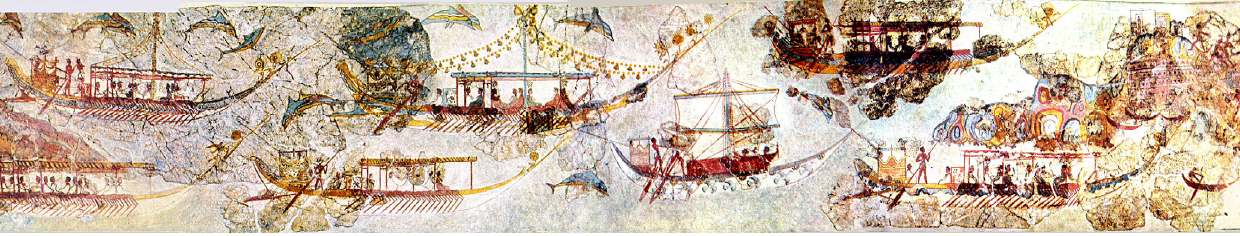
Figure 19. Minoan fresco, ship procession from Akrotiri c. 2000–1500 BC. Sophisticated ships with different decorations suggesting stratification. In the middle, a sailing boat loaded with goods [213].